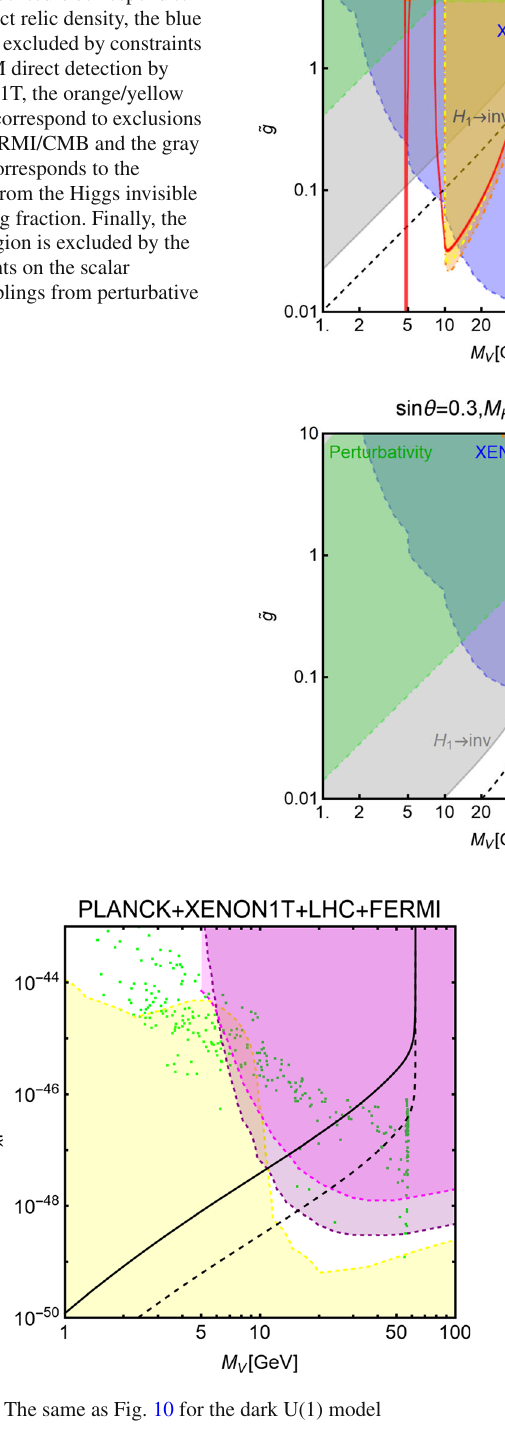
, M , M H ± . As a con- A 0 H 0